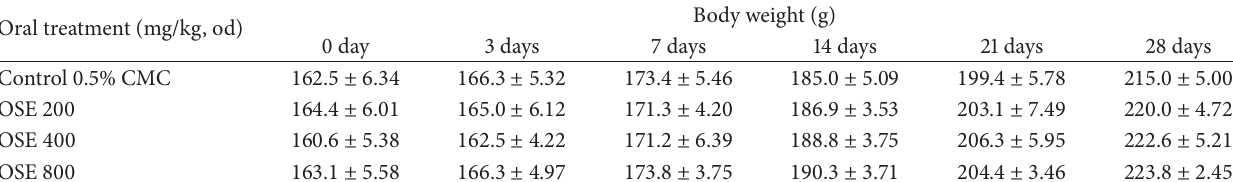
Table 1: Effect on body weight after 28 days oral administration of OSE.